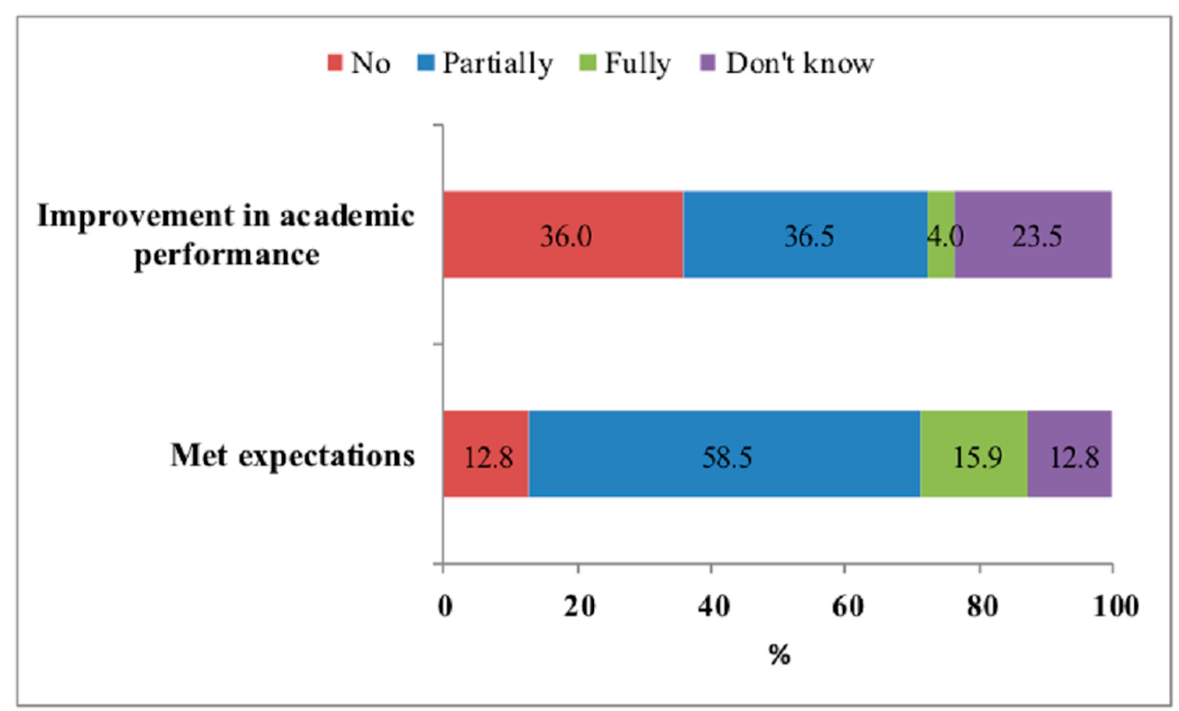
Figure 3. Satisfaction with neuroenhancer use for the university students from Cluj-Napoca, Rouen, and Opal Coast University.